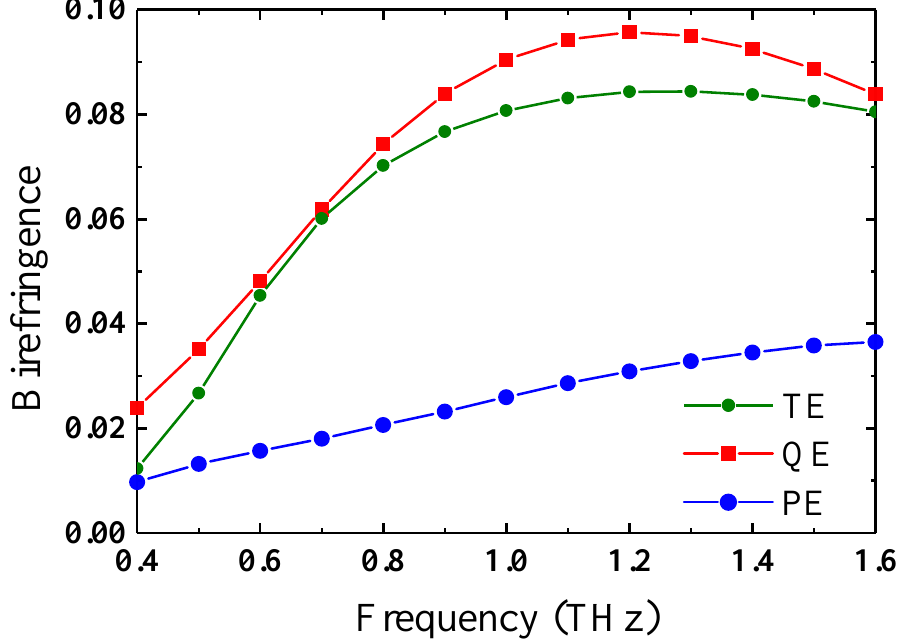
Figure 3. Response of the TE, QE, and PE designs to birefringence.